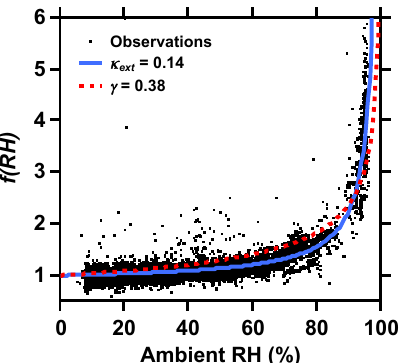
Figure A2. Ratio of optically determined κ ext to chemically deter- mined κ chem as a function of particle geometric median diameter and κ chem . Values of κ ext were calculated for a lognormal particle size distribution with a geometric standard deviation of 1.5 and a geometric median diameter given by the abscissa. Points are instan- taneous values of κ ext /κ chem determined from the in situ f (RH) and composition measurements.